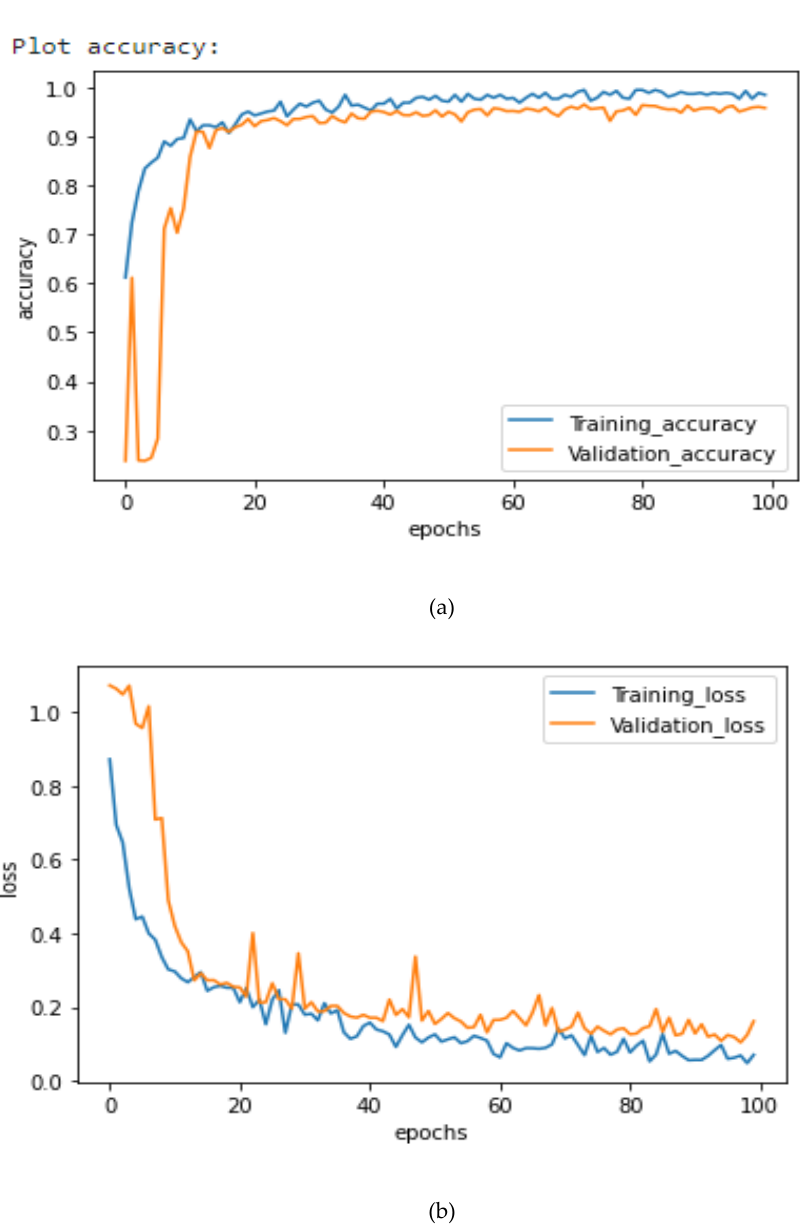
Figure 6. AlexNet Loss and Accuracy curves. ( a ) Training and Validation Accuracy, ( b ) Training and Validation Loss.